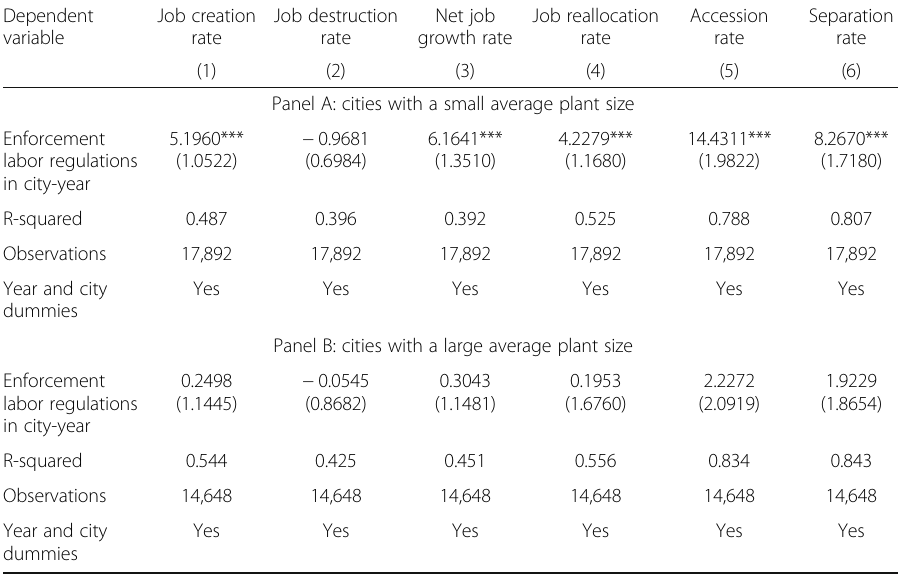
Table 11 Enforcement of labor regulations and job flow rates, by average plant size in the